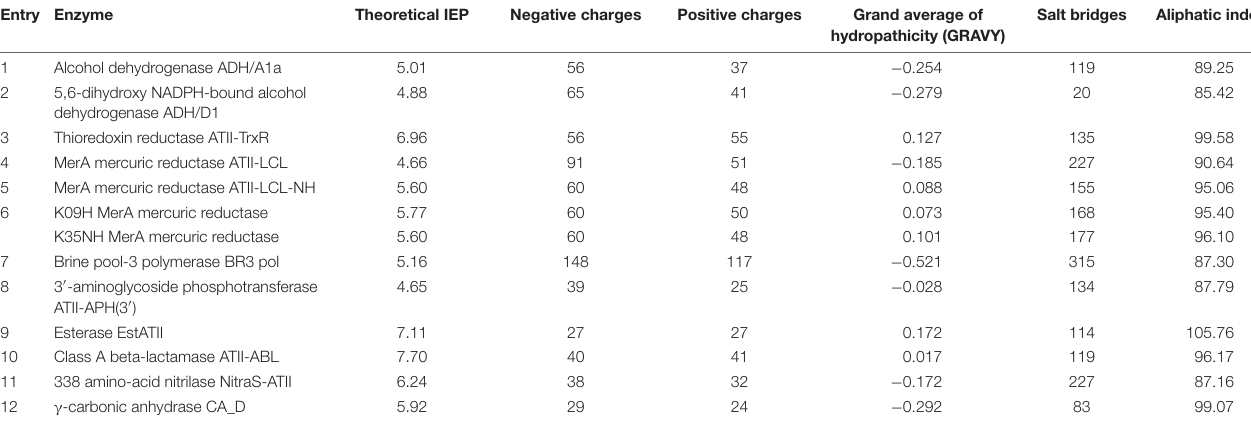
TABLE 2 | Physiological characteristics of extremozymes from the Red Sea brine pools. Entry Enzyme Theoretical